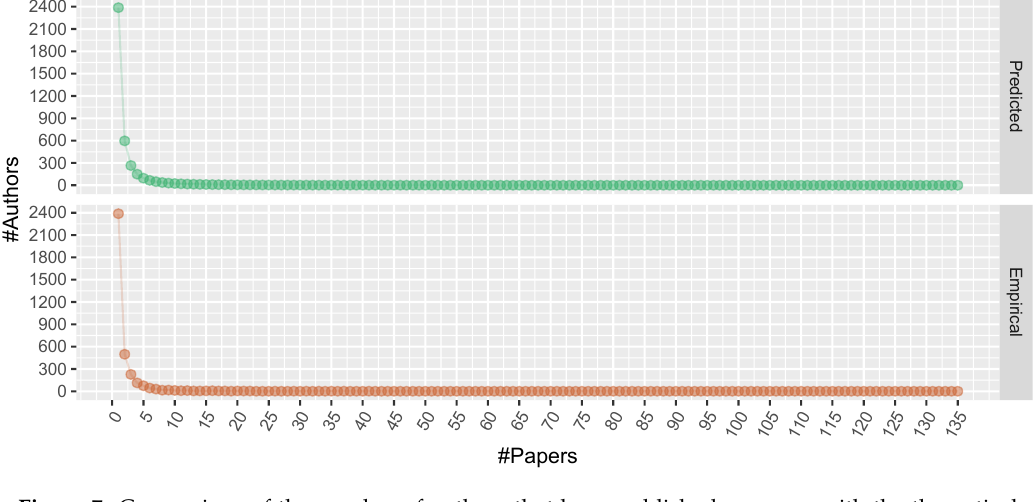
Figure 7. Comparison of the number of authors that have published n papers with the theoretical values predicted by Lotka’s law.